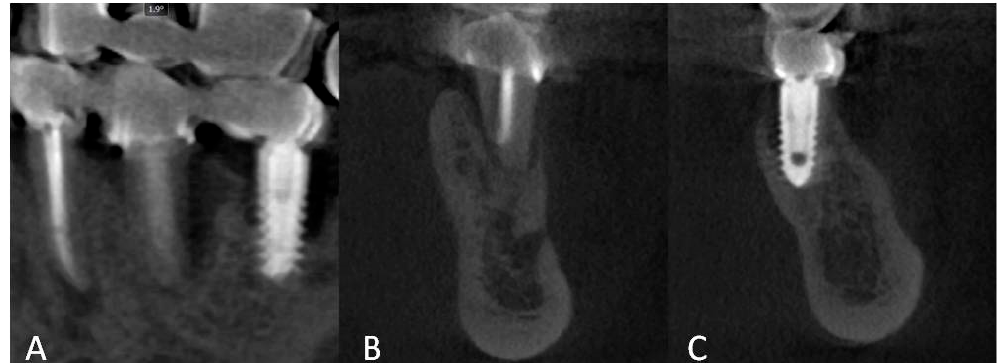
Figure 1. Rx Opt from 2010, taken when treating the patient.